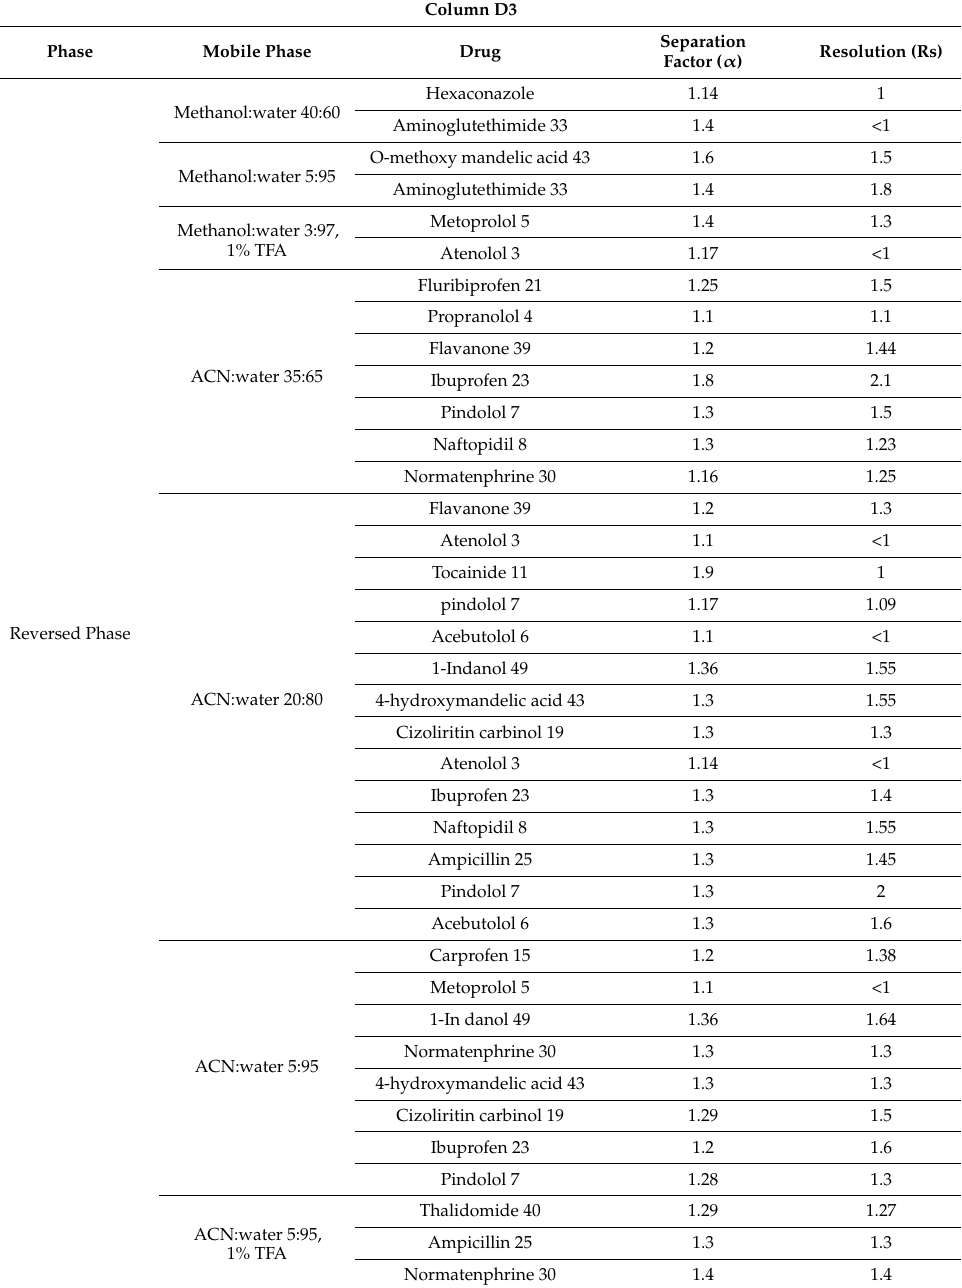
Table 4. Chromatographic parameters, separation, and resolution factors for the significantly resolved compounds on D3 (encapsulated) column, using reversed mobile phases, flow rate: 1 µ